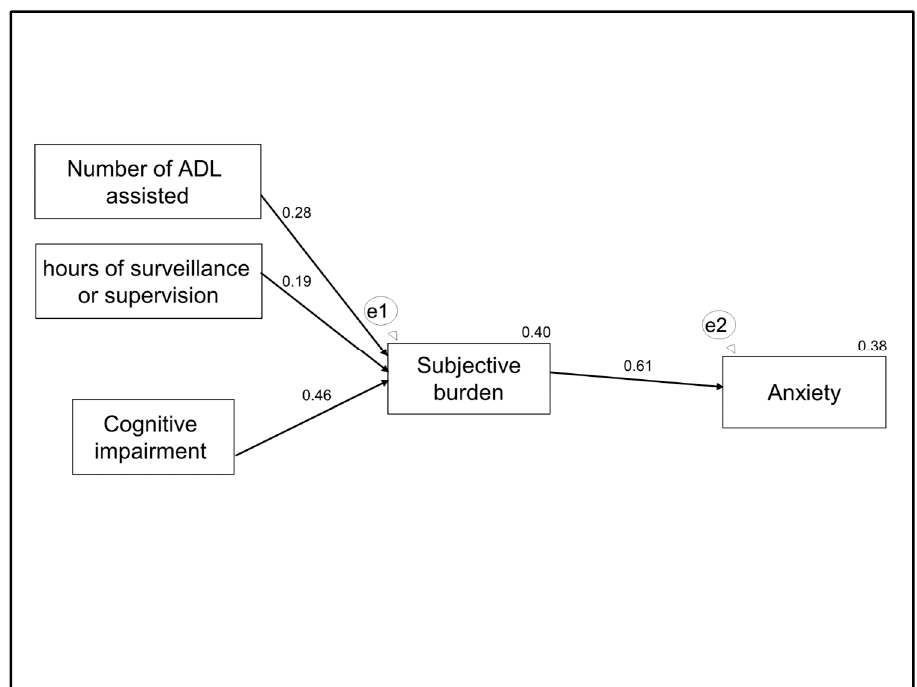
Figure 3. The final model. Notes: numbers by arrows represent standardised regression coefficients; numbers on the right upper corner of the boxes represent r 2 of the partial regression of each variable. Notes: e1 and e2 are latent errors. Abbreviation: ADL, activities of daily living.